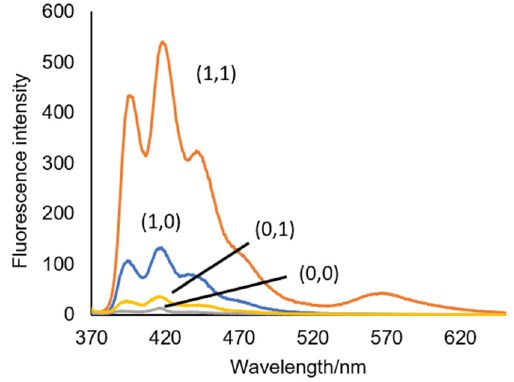
Figure 3. Emission spectra of 6 in 1:9 ( v / v ) MeOH/H 2 O excited at λ ex = 368 nm. The numbers in parentheses are the binary input conditions, as given in Table 2.